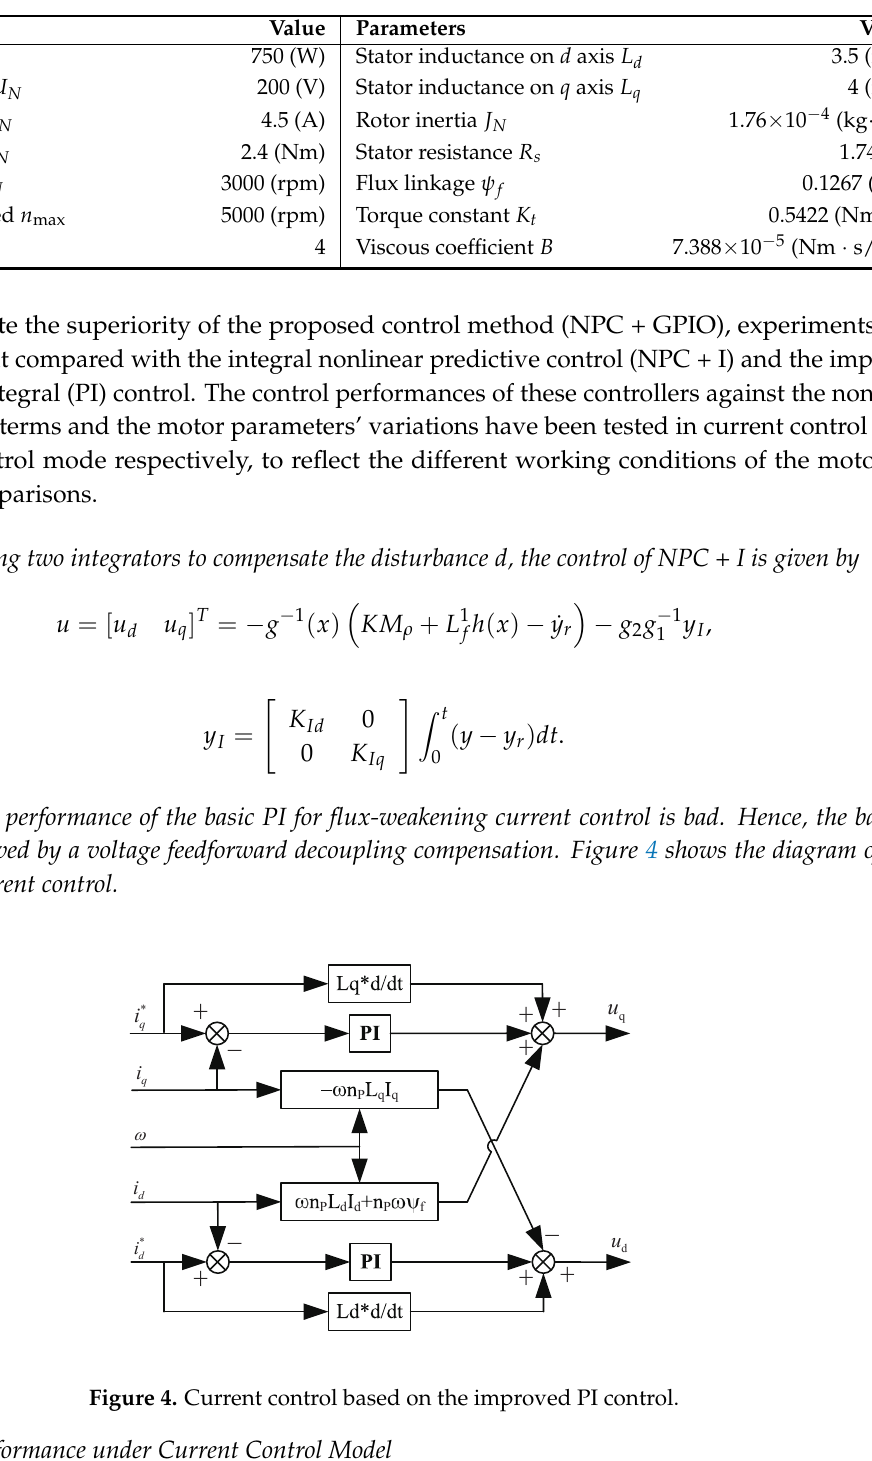
Table 1. Motor nominal parameters.